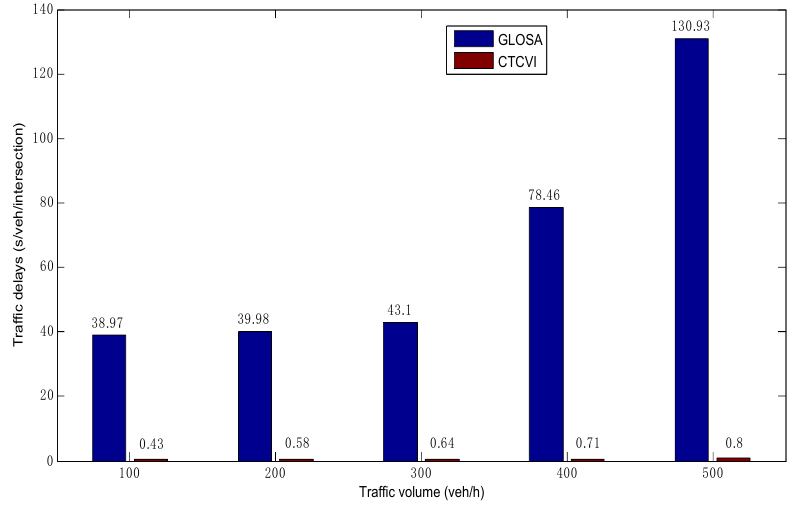
Figure 13. Comparison of average traffic delays.